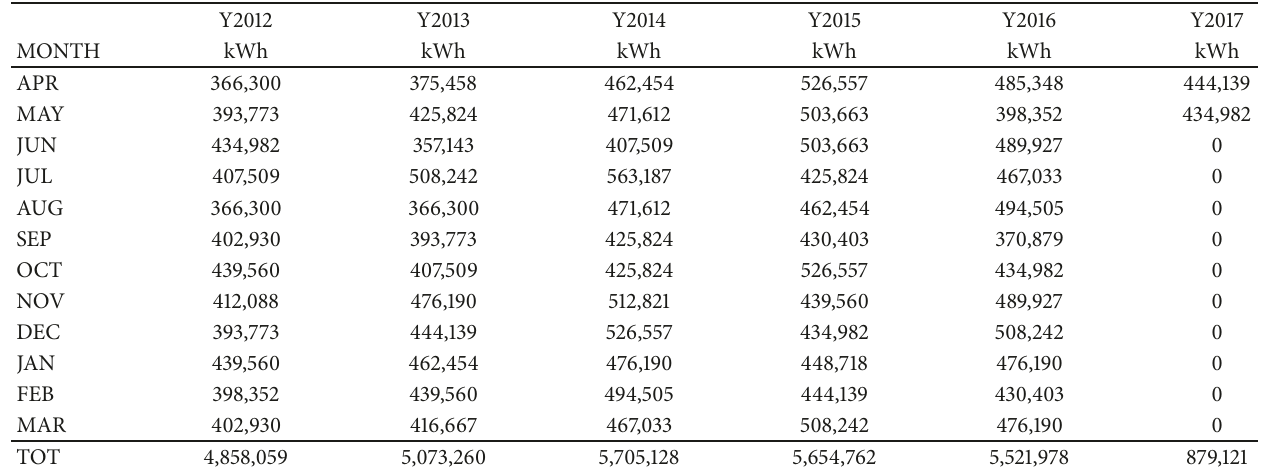
Table 4: Electrical power